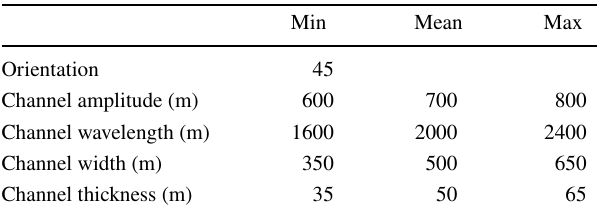
Table 5 Input parameters used in lithofacies modelling